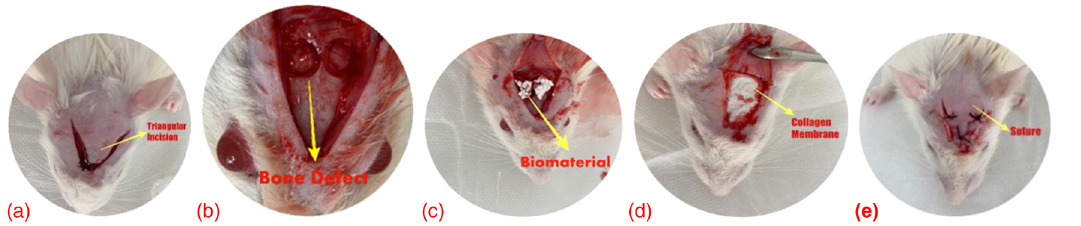
Figure 1: In vivo testing: ( a ) triangular incision in the calvaria region; ( b ) bone defect prepared; ( c ) insertion of biomaterial; ( d ) collagen membrane in the subcutaneous region; ( e ) suture with 5.0 silk to close the surgical